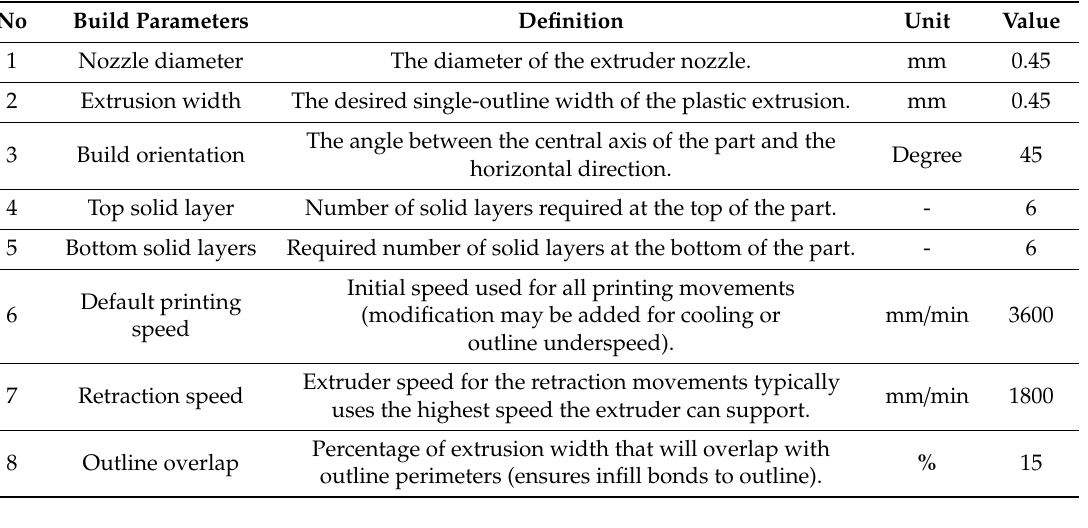
Table 3. FDM fixed parameters of the